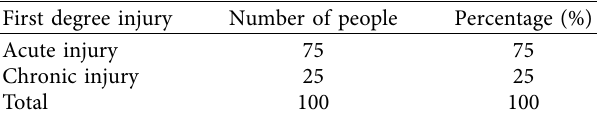
Figure 6: Proportion of athletes with ankle injuries in 2019 and 2020. (a) Proportion of athletes with ankle injuries in 2019. (b) Proportion of athletes with ankle injuries in 2020. Table 3: Acute injury primary injury questionnaire.